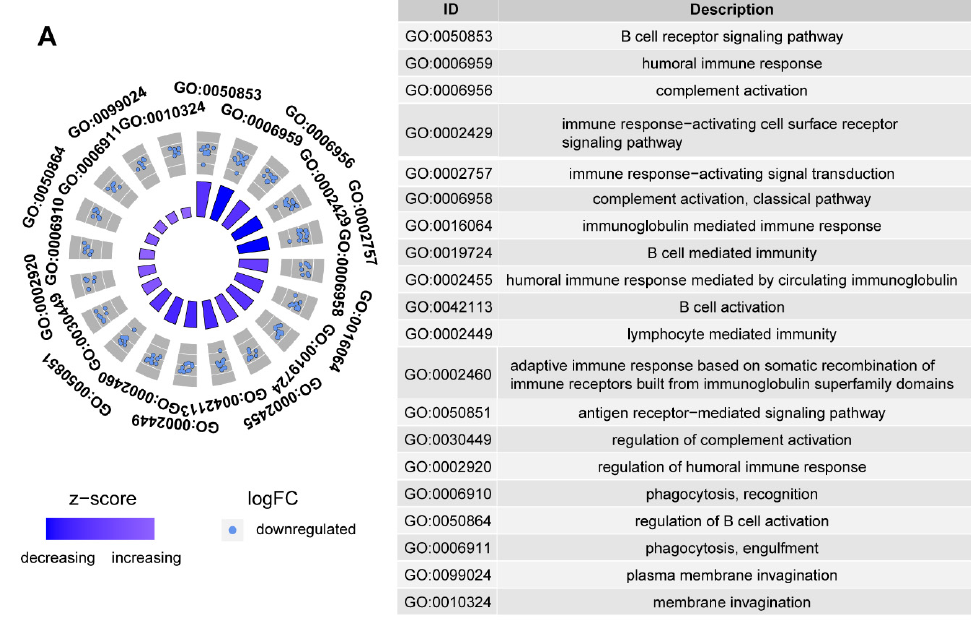
Figure 5. Enrichment analysis results relevant to TMERSscore. ( A ) Gene ontology analyses of the DEGs. ( B ) KEGG analyses of the pathways of the DEGs. ( C ) GSEA of TMERSscore demonstrates the activation pathways of different subgroups.